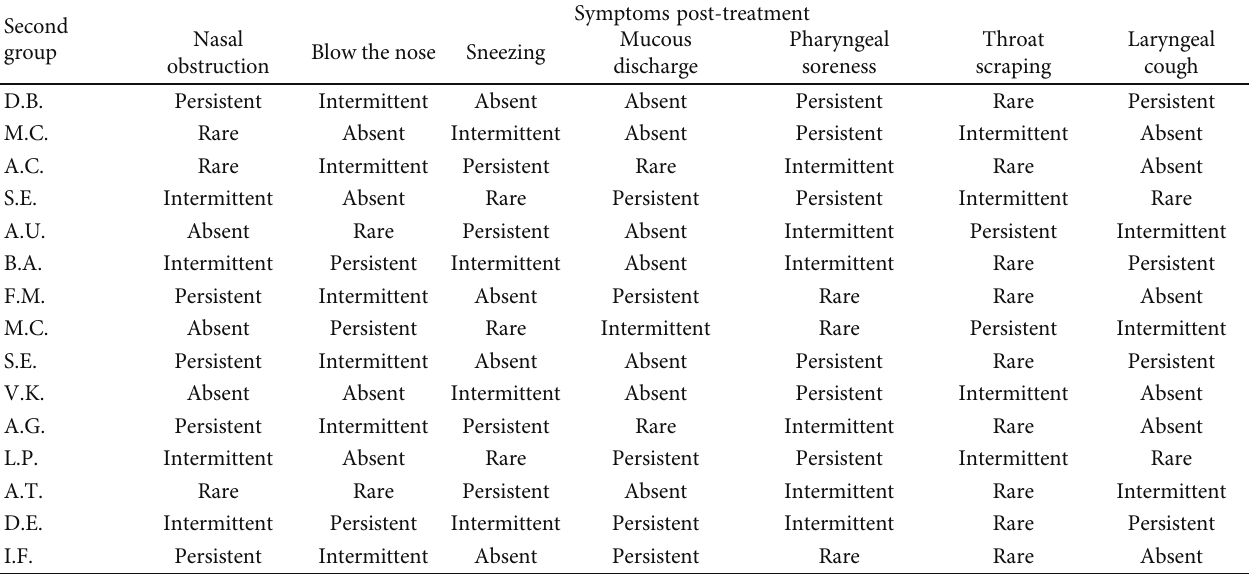
Table 5: Description of symptoms in the second group (commercial spray) after treatment.